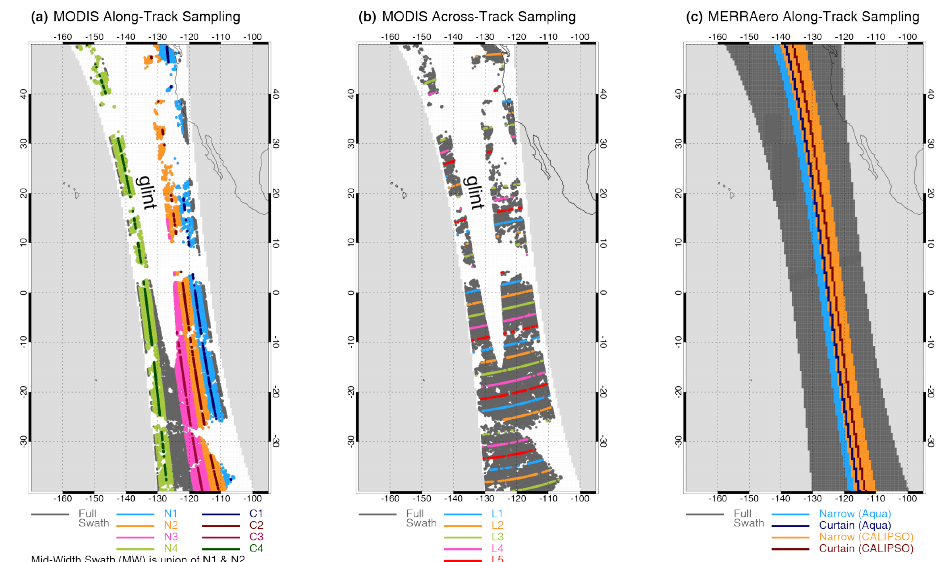
Figure 2. Spatial sampling strategies used in this paper illustrated for an example portion of an over-ocean orbit track of the Aqua spacecraft on 5 June 2010. (a) Along-track sampling illustration. The colored dots indicate the locations of the MODIS AOT retrievals, with the grey dots indicating the full MODIS swath (MO). Overlaid on the grey dots are different colors for our various along-track sampling strategies (N1=light blue, N2=orange, N3=magenta, N4=light green, C1=dark blue, C2=dark red, C3=deep purple, C4=dark green, and MW=combined N1 and N2 swath). The light-grey shaded areas on the left and right side of the figure are outside the swath, while the central white region (labeled “glint”) is where no aerosol retrievals are made due to glint. Remaining patchy white areas are where aerosol retrievals were not made due to clouds. (b) As in (a) except illustrating across-track sampling following Geogdzhayev et al. (2013). (c) Along-track sampling strategy for MERRAero model output. Dark grey shading is the MODIS Aqua full swath. Light and dark blue are respectively the narrow and curtain width sampling along the Aqua ground track. Orange and dark red are respectively the narrow and curtain width sampling along the CALIPSO ground track. Note the absence of cloud or glint features in the model sampling.